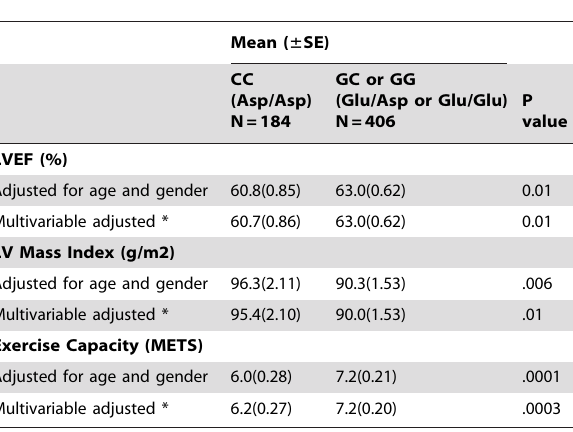
Table 3. Association of CC (vs. GG or CG) genotype at rs2296545 with continuous measures of cardiovascular structure and